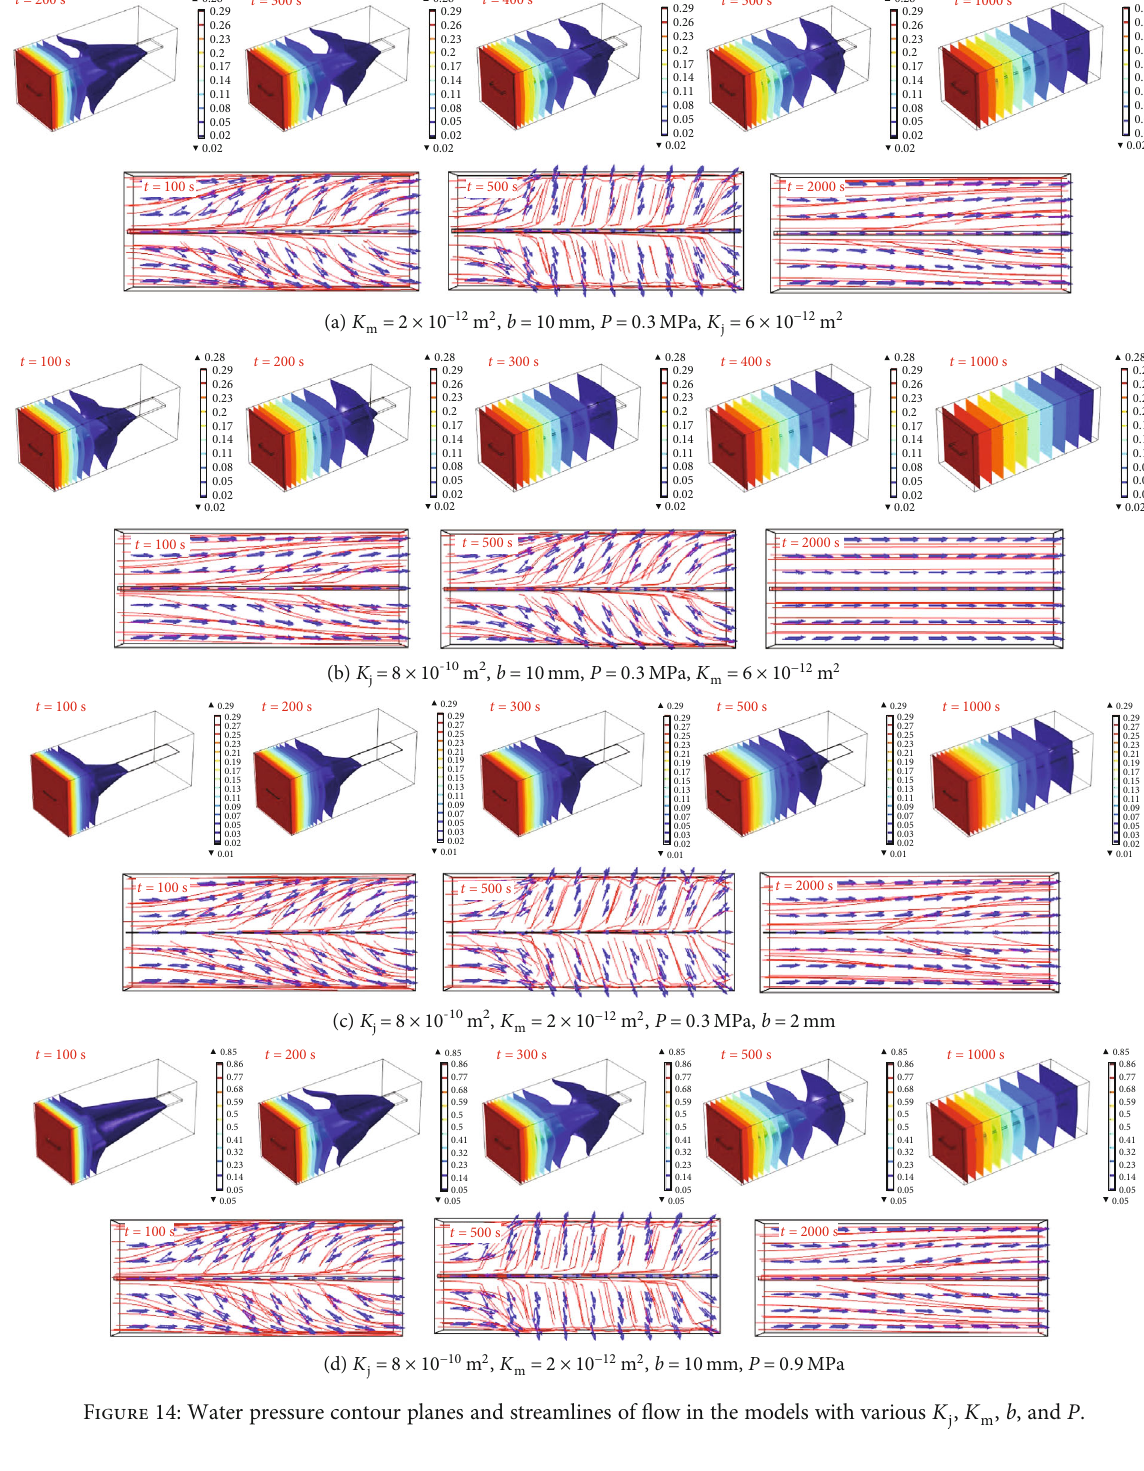
Figure 14: Water pressure contour planes and streamlines of fl ow in the models with various K